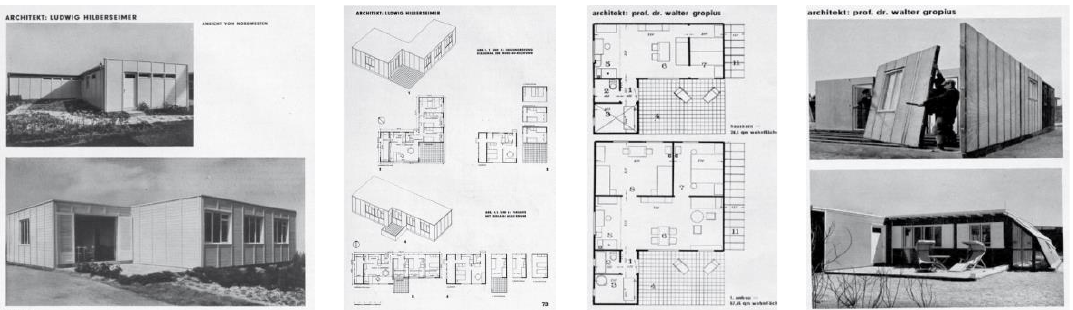
Figure 3 Growing House (Das wachsende Haus, 1931) working groups studies on standardization of housing, (Schlorhaufer, 2020).